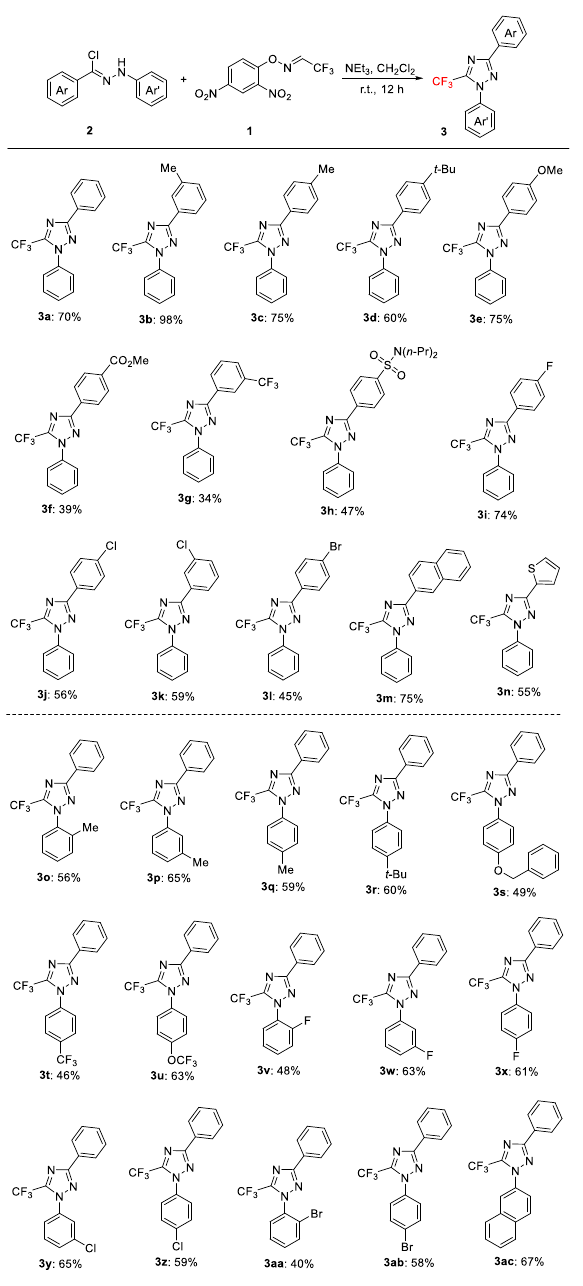
Figure 2. Scope of the hydrazonyl chlorides. Reaction conditions: 2 (0.30 mmol), 1 (0.20 mmol), NEt 3 (0.60 mmol, 3.0 equiv), CH 2 Cl 2 (1.0 mL), r.t., 12 h, in benchtop air atmosphere. Isolated yields (calculated on basis of starting material 1 ).